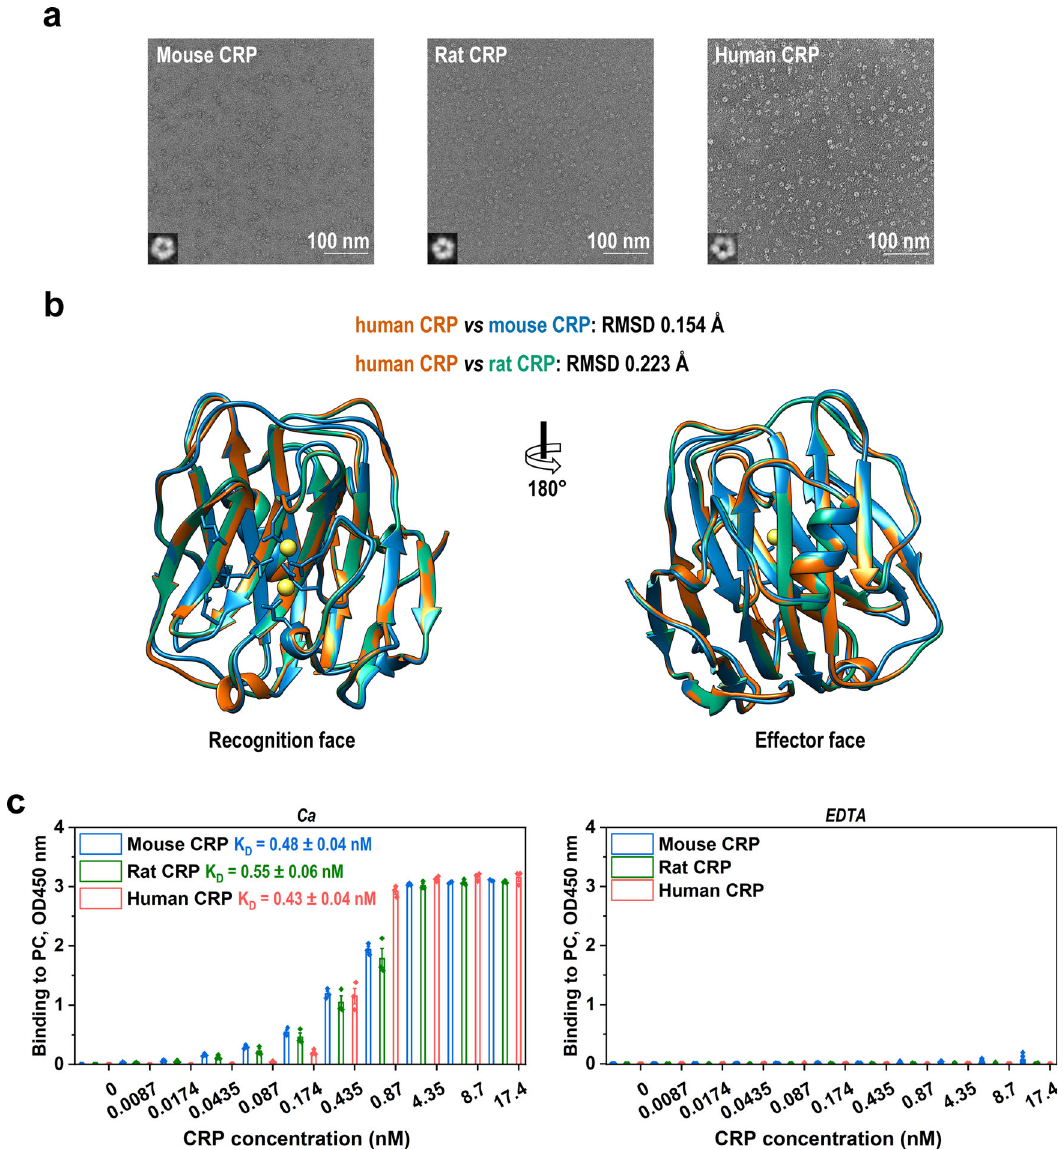
Fig. 2 The native structure and associated activities of CRP are evolutionarily conserved. a The pentameric assembly of puri fi ed mouse, rat, and human CRP was examined with electron microscopy and single-particle analysis. The diameters of pentameric class averages of the mouse (181 particles), rat (209 particles), and human CRP (208 particles) are 10.98, 10.97, and 10.24 nm, respectively. b The subunit structures of mouse and rat CRP were generated with SWISS-MODEL using subunit A from the crystal structure of human CRP (PDB 1B09) 56 as the template. c The binding of mouse, rat, and human CRP to immobilized PC-KLH were examined with ELISA in the presence (left; n = 3 independent experiments) or absence of calcium (right; n = 6 independent experiments for mouse CRP; n = 3 independent experiments for rat and human CRP). Neither their native structures nor calcium-dependent PC-binding activities exhibited signi fi cant difference. Data are presented as mean ±